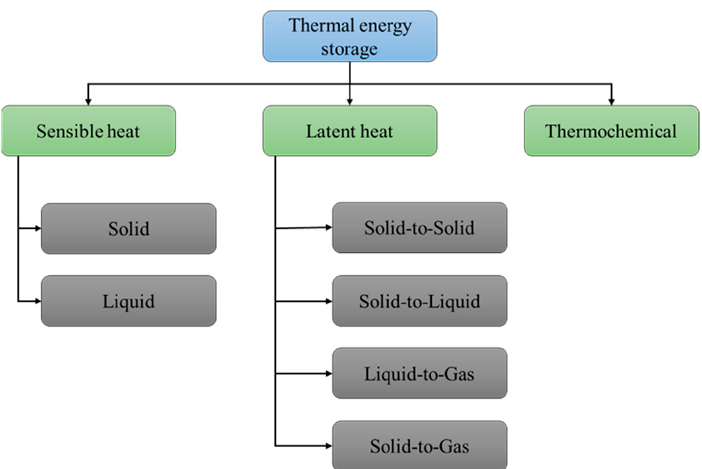
Figure 1. TES technologies with a focus on materials.